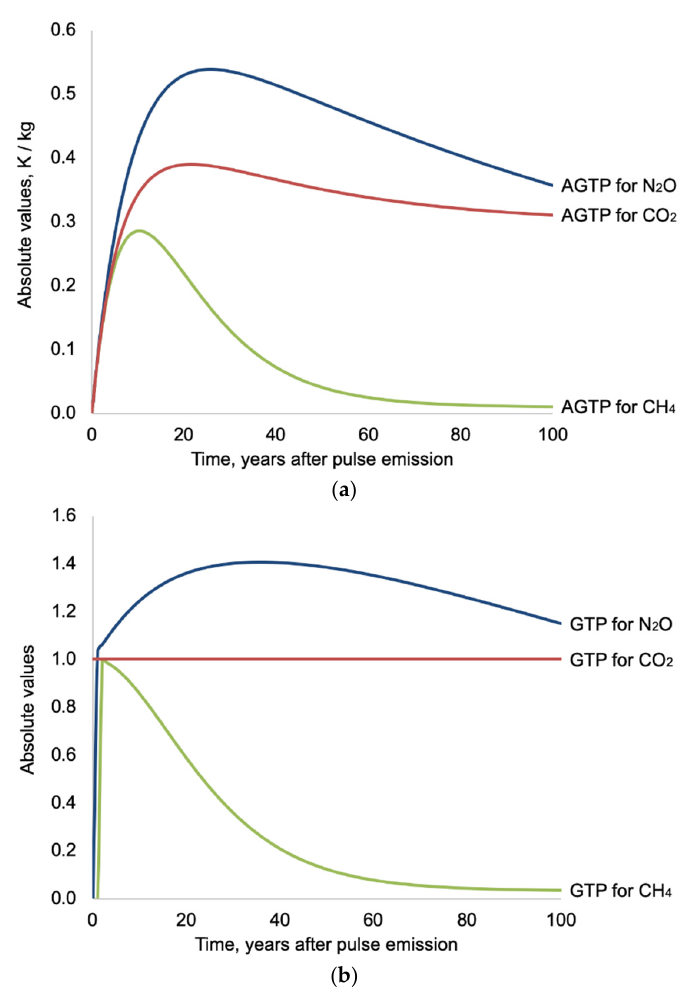
Figure 6. Normalized ( a ) absolute global temperature change potential (AGTP) ( b ) GTP values as a response to emission of CO 2 , N 2 O, and CH 4 at year zero. The values are normalized to the maximum value of the corresponding AGTP or GTP of each gas, unitless.